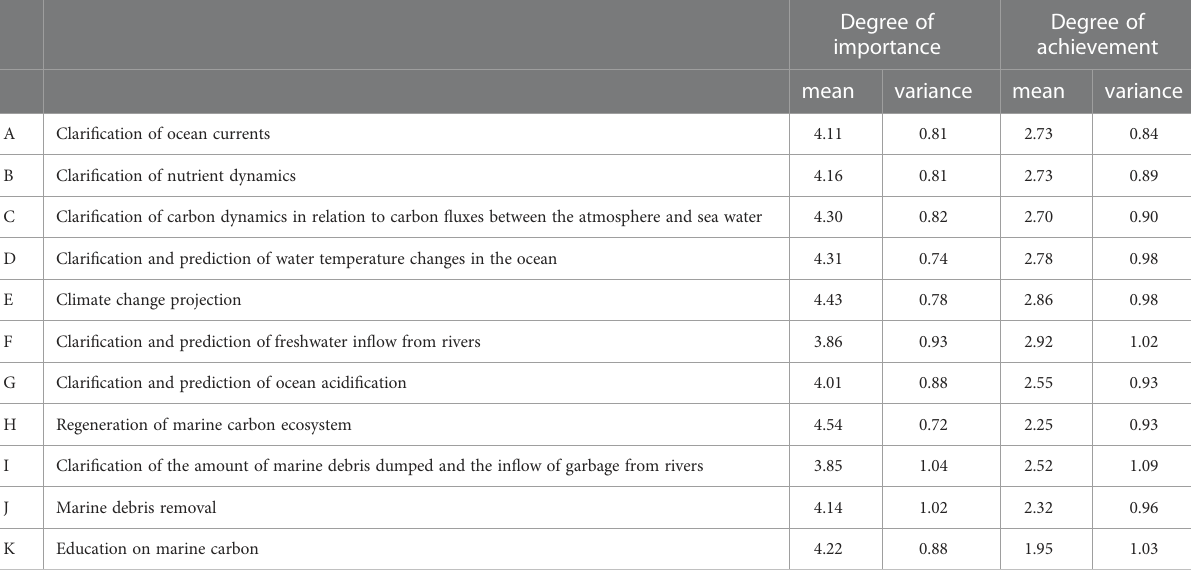
TABLE 2 The average and variance of the answers to the eleven questions regarding marine